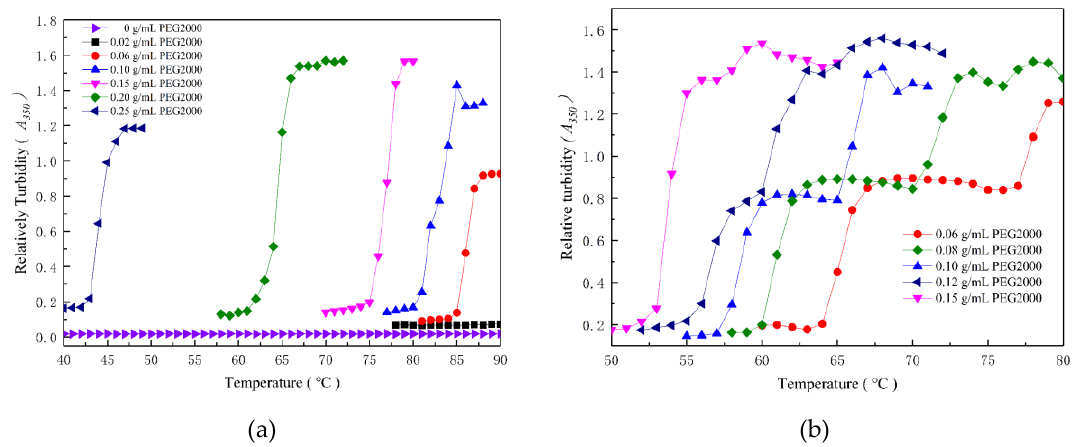
Figure 4. Effects of PEG2000/Na 2 CO 3 concentration on 25 μmol/L E-C phase transitions temperature. ( a ) 0.4 mol/L Na 2 CO 3 ; ( b ) 0.5 mol/L Na 2 CO 3. ( a ) 0.4 mol / L Na 2 CO 3 ; ( b ) 0.5 mol / L Na 2 CO